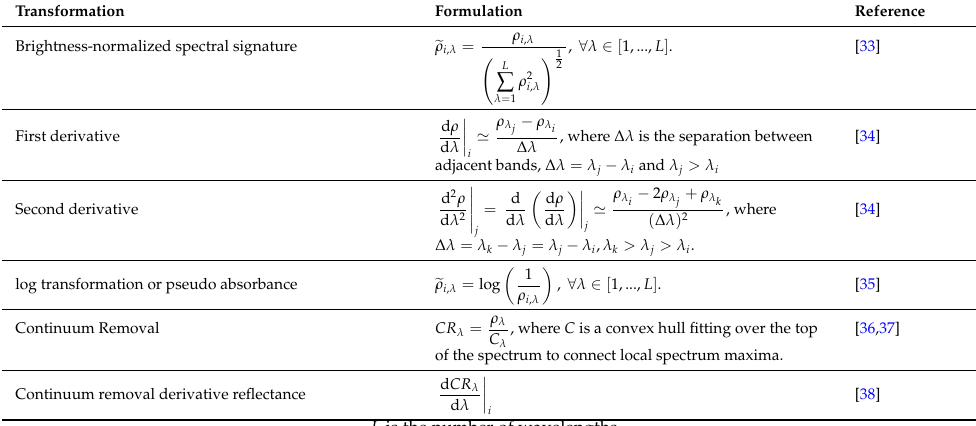
Table 3. Transformed spectral